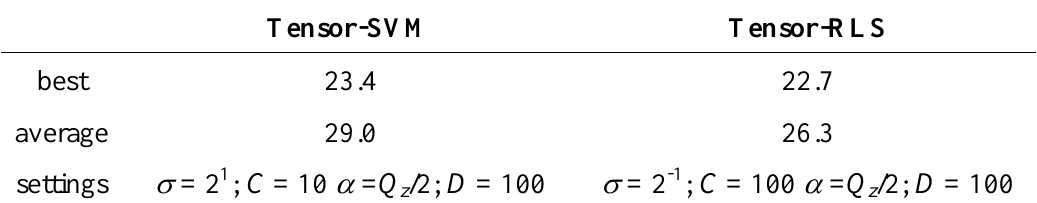
Table 7. Results for the 3-class classification